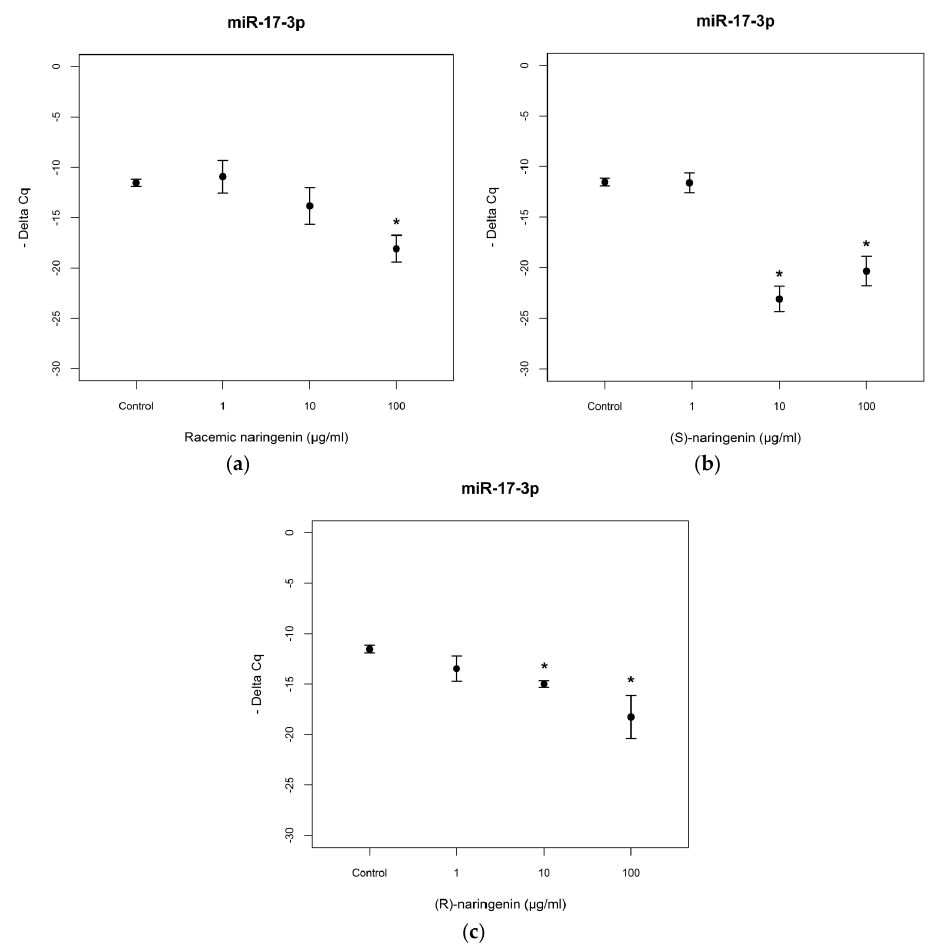
Figure 2. Expression levels, reported as Delta Cq, of miR-17-3p in Caco-2 cells treated with increasing concentrations of ( a ) racemic naringenin, ( b ) ( S ), and ( c ) ( R ) naringenin (1–100 μ g/mL). * Indicates statistically significant differences between treated and untreated cell cultures, as reported in the text.